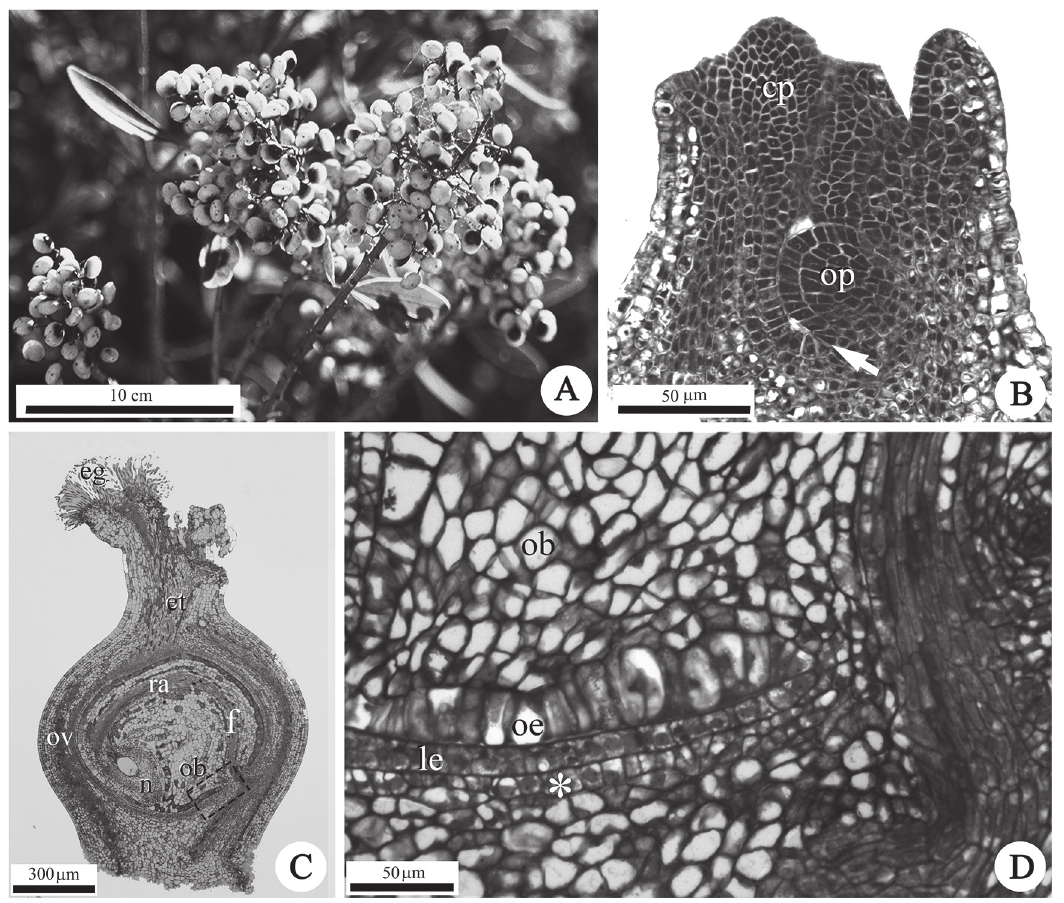
Fig. 1 - Morphology and anatomy of fruits and flowers of Lithraea brasiliensis Marchand. A. Photomacrograph of the ripe fruits. B, D-G. Longitudinal sections of flowers and fruits at different developmental stages. B. Detail of an immature gynoecium during the emergence of the ovule. Arrow indicates the limitrophe point between the locular protoderm and the protoderm of the ovular primordia. C. Pre-anthesis floral bud. Frame indicates the placental region, the place for detailed analysis of the differentiation of the layers of the endocarp in Figure D and Figures 2A to C. D. Pre-anthesis floral bud. Locular epidermis is one layered. Crystalliferous layer (asterisk). cp = carpel primordial; eg = stigma; et = style; f = funiculus; le = locular epidermis; n = nucellus; ob = funicular obturator; oe = ovular epidermis; op = ovule primordia; ov = ovary; ra =